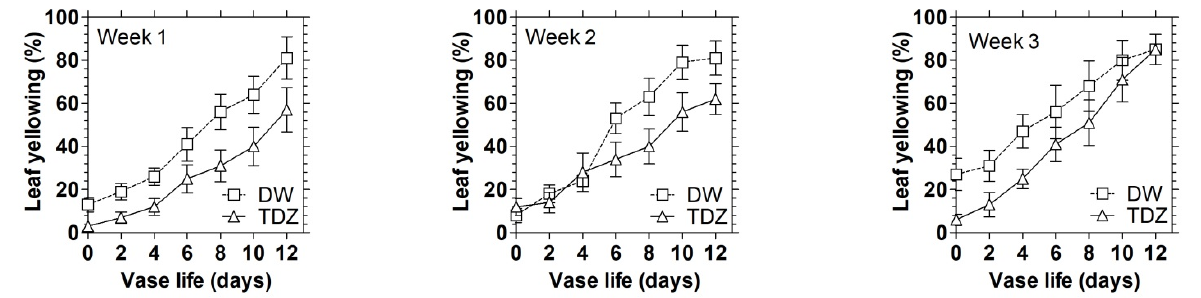
Figure 6. Changes in yellowing of D. solida leaves pulsed with 10 µ M TDZ or distilled water (DW; control) for 24 h, packed in a BOPP bag, stored at 10 °C for 1 ( Left ), 2 ( Middle ) and 3 weeks ( Right ), and then transferred to distilled water in a controlled environment room.